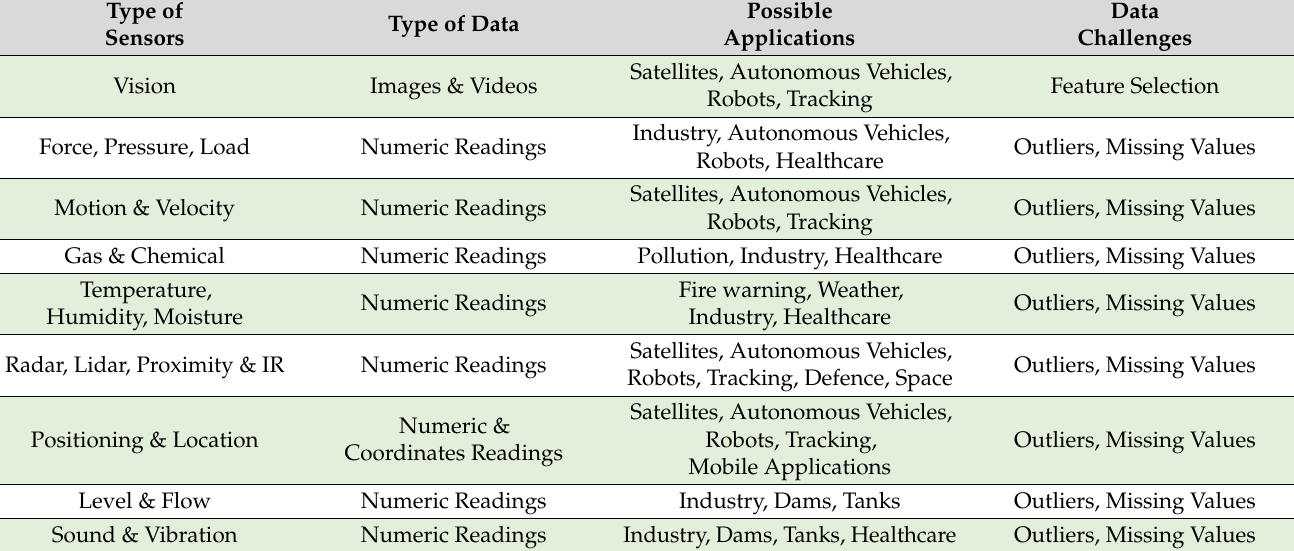
Table 2. IoT paradigm concerning data sources, applications, and data